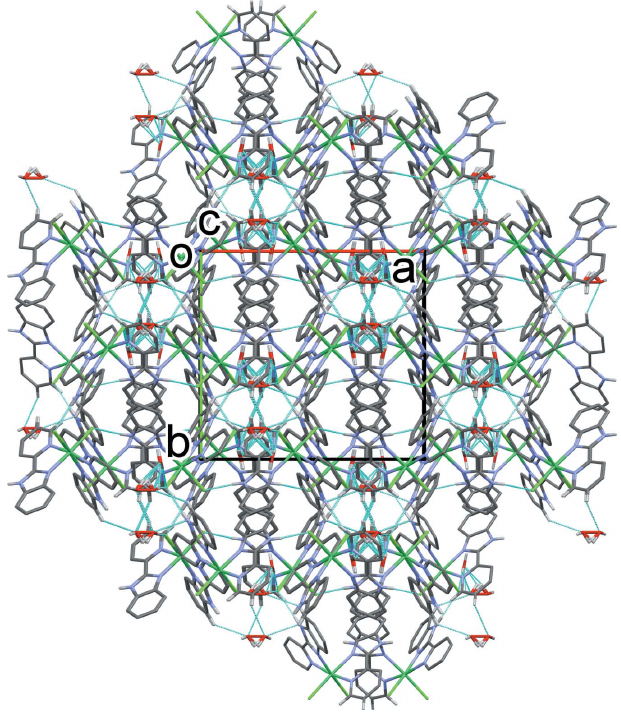
Figure 3 A view along the c axis of the crystal packing of the title complex. For clarity, only the H atoms involved in hydrogen bonding (dashed lines; Table 1) have been included.